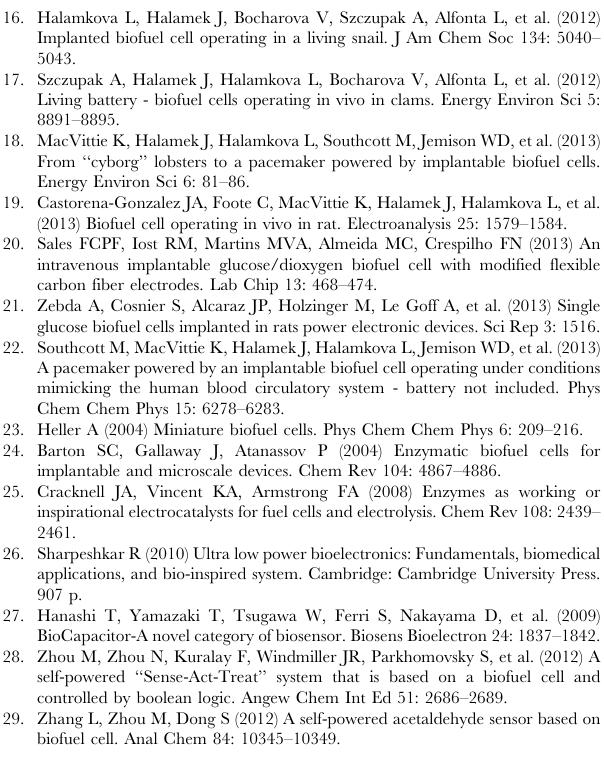
for sugar monitoring. The dashed line represents the background signal from the electronics. (TIF) Figure S8 Oxygen sensing calibration. Response unit from the test of the wireless self-powered device for oxygen monitoring. The dashed line represents the background signal from the electronics. (TIF) Table S1 Electrode characteristics. Electrode performance, from order of appearance in the Materials section in the manuscript. (TIF) Text S1 Supporting Information Text.